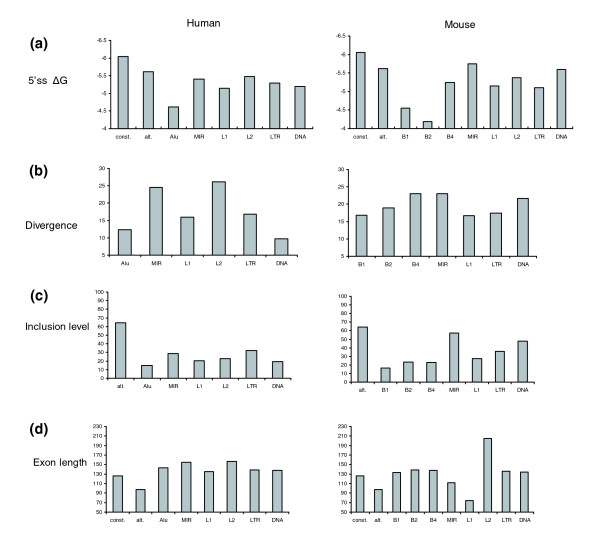
Characteristics of the exonized TEs. (a) The free energy resulting from the base pairing of the 5'ss with U1 snRNA (ΔG) for the indicated exonized transposed elements (TEs). 'const.' and 'alt.' indicate conserved human and mouse constitutively spliced and alternatively spliced exons, respectively. (b) The divergence in percentage from the consensus sequence. (c) The average inclusion level. (d) The average exon length.